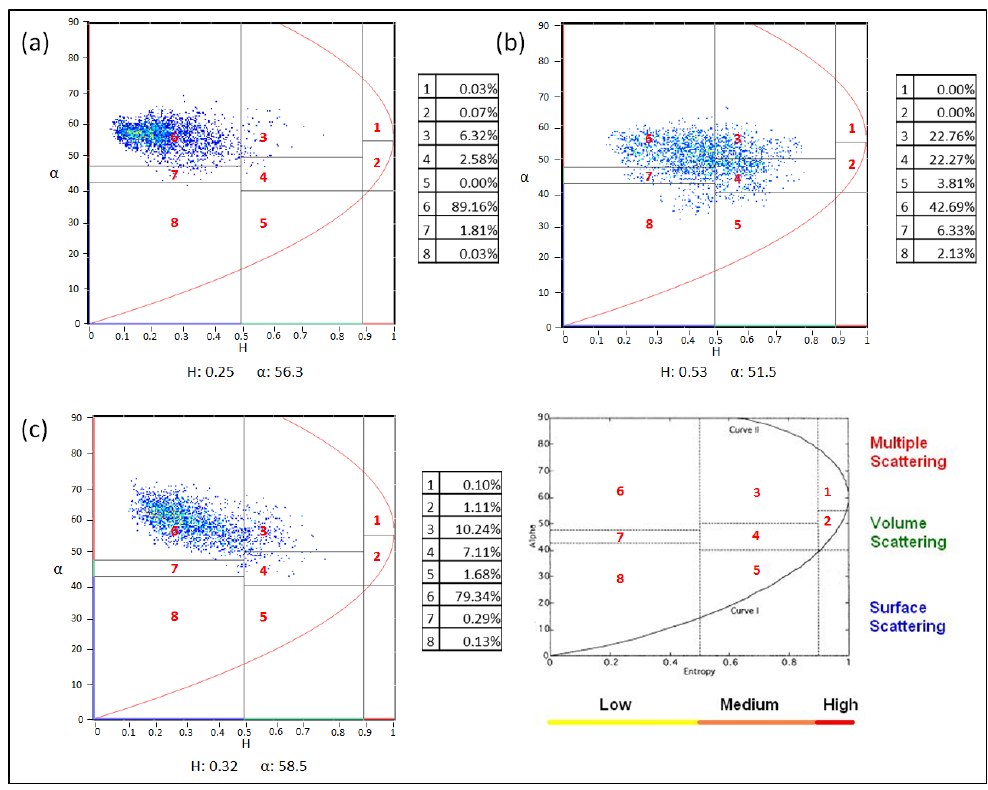
Figure 16. Wetlands Cloude-Pottier H/α decomposition based on RADARSAT-2